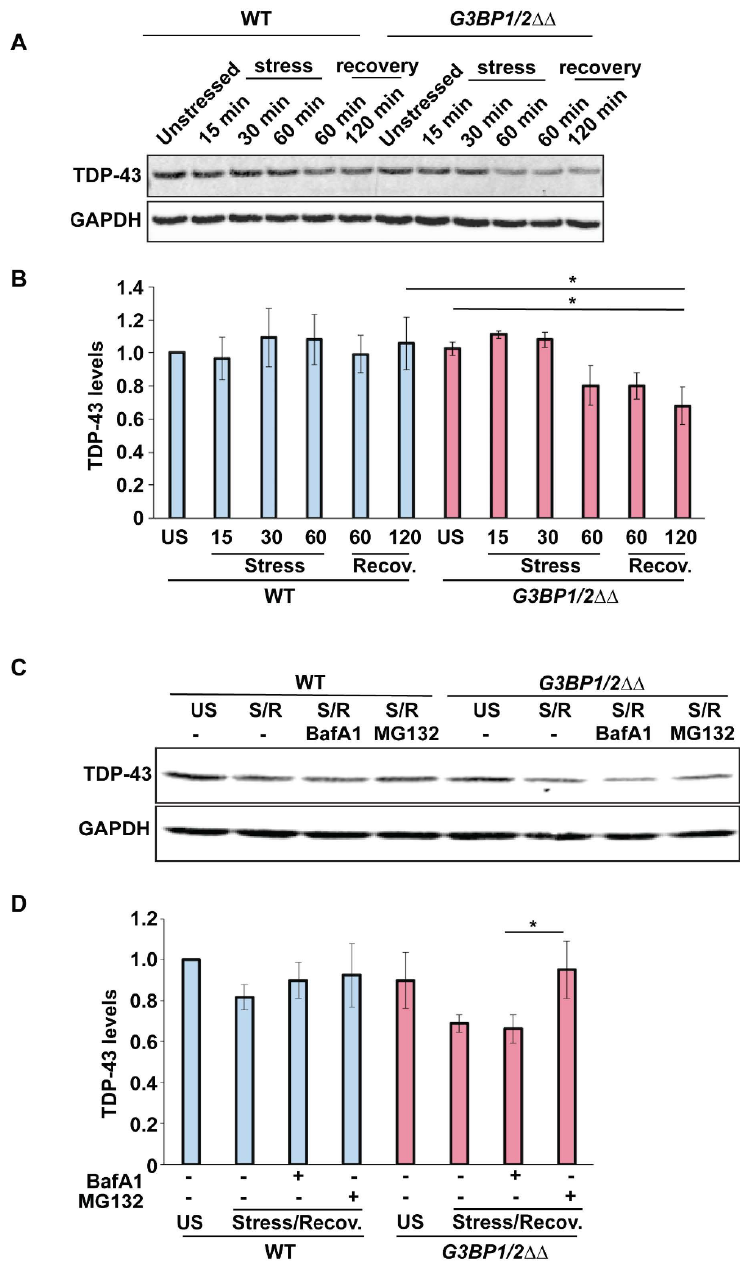
Figure 6. SG assembly correlates with maintenance of TDP-43 protein levels during stress recovery. ( A ) U2-OS (WT) and G3BP1/2ΔΔ cells were left unstressed, stressed with 0.5 mM sodium arsenite for 1 h or stressed with 0.5 mM sodium arsenite for 1 h followed by recovery for 2 h. Westerns were carried out to assess TDP-43 protein levels. ( B ) Quantitation of data in ( A ). Data generated from 3 biological replicates with mean ± s.d shown; TDP-43 levels were normalized to GAPDH loading controls. An ANOVA with Tukey’s post-hoc test was used to assess significance. ( C ) U2-OS (WT) and G3BP1/2ΔΔ cells were left unstressed (US), stressed with 0.5 mM sodium arsenite for 1 h, followed by recovery for 2 h (S/R). Proteasomal (10 μM MG132) and Lysosomal (0.5 μM Bafilomycin A1) inhibitors were added co-incident with arsenite addition. Westerns carried out as described in ( A ). ( D ) Quantitation of ( C ), as described in ( B ). An ANOVA with Tukey’s post-hoc test was used to assess significance (* indicates